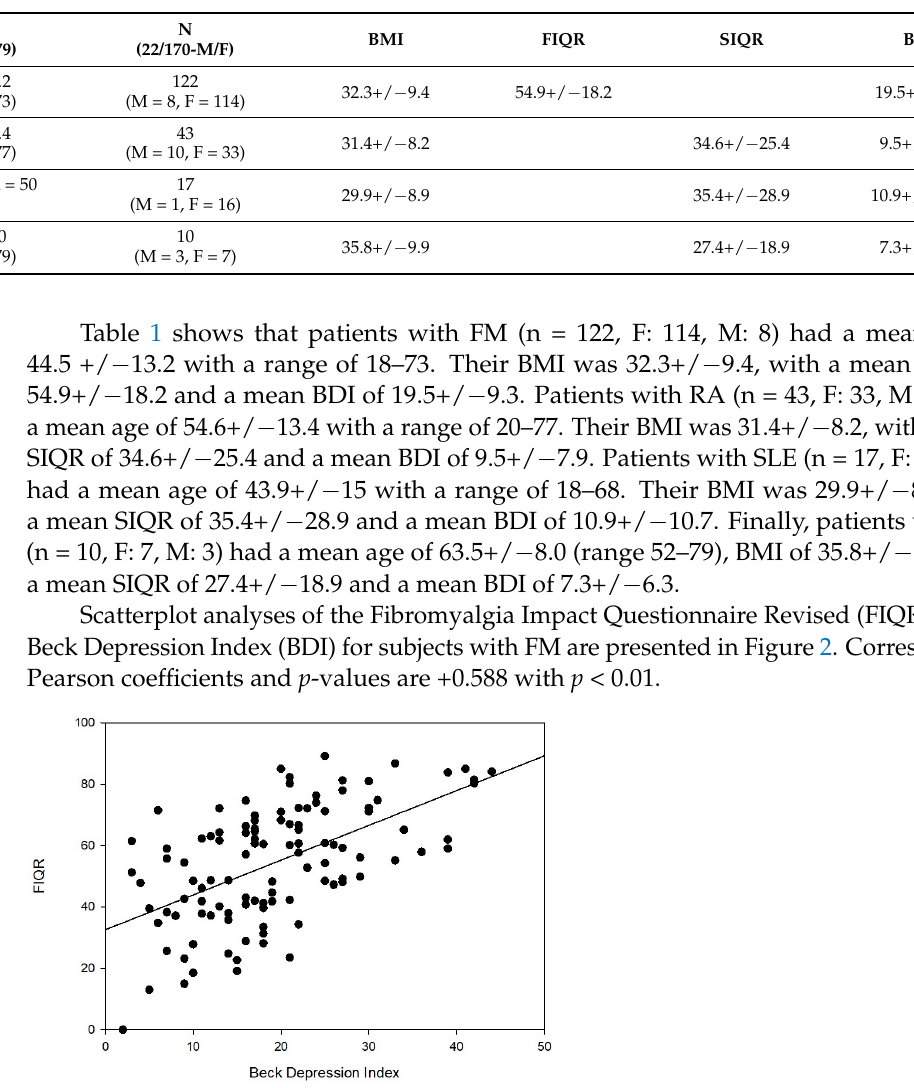
Table 1. Clinical characteristics of all subjects. Values expressed as mean +/ − /sd; N = number of subjects, Age (range). FM: fibromyalgia, RA: rheumatoid arthritis, SLE: systemic lupus erythemato-